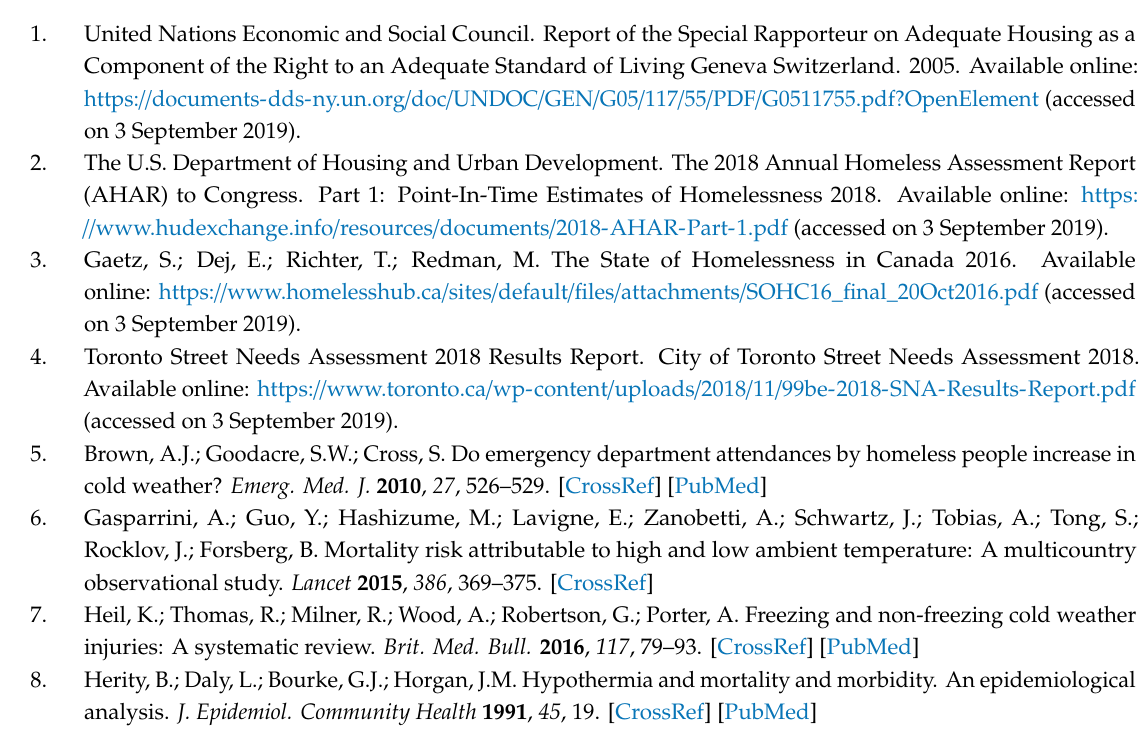
Table S1: Odds ratios for the association between a 5 ◦ C drop in mean hourly wind chill and hypothermic injury or